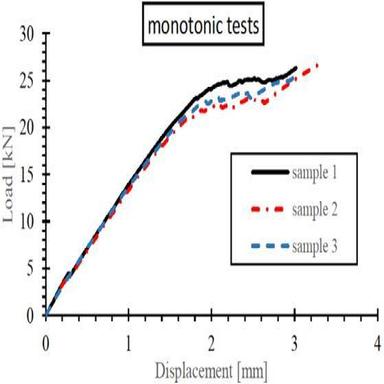
Plots of the Load-Displacement curves measured from monotonic tests up to failure on MTCT samples.